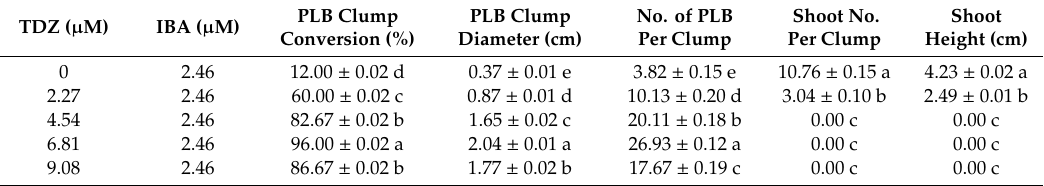
Table 3. The conversion of micro-rhizome to globular-shaped clump bearing PLBs after eight weeks of culture on Murashige and Skoog medium containing 17.76 µ M BA and 2.46 µ M indole-3-butyric acid (IBA) with di ff erent concentrations of TDZ, respectively along with adventitious shoot numbers and their